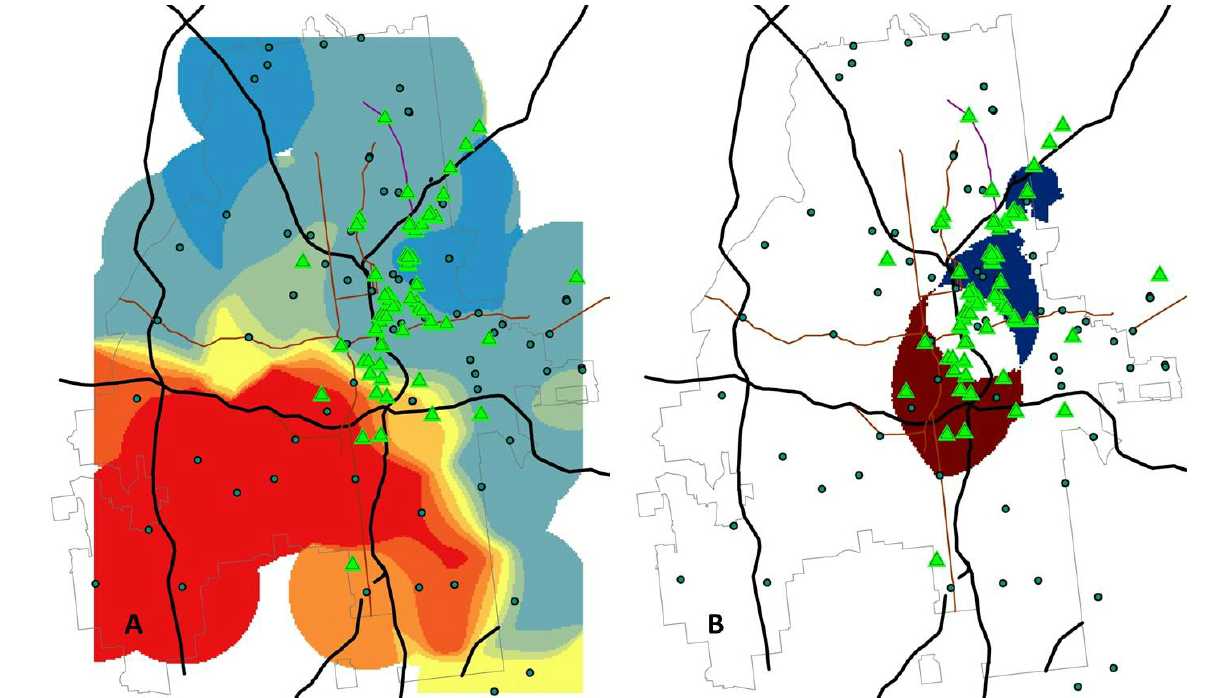
Figure 10. Application of two density metrics to evaluate recruitment for HIV prevention studies in Atlanta, showing recruitment venues currently in use for two HIV prevention studies (green triangles). Panel A shows few recruitment locations in the southwestern part of Atlanta, where there are relatively more young black application users than white users. Panel B uses the formula (Density of young black users > mean+2 standard deviations) – (Density of young white users > mean+2 SD). Regions where the values of this equation are -1 (blue shading, indicating areas with extremes of density for young white but not young black users), 1 (red shading, indicating areas with extremes of the density for young black but not young white users), and 0 (white shading indicating areas that are either not extremes of either density or are extremes for both races) can then be compared to the locations of current recruitment